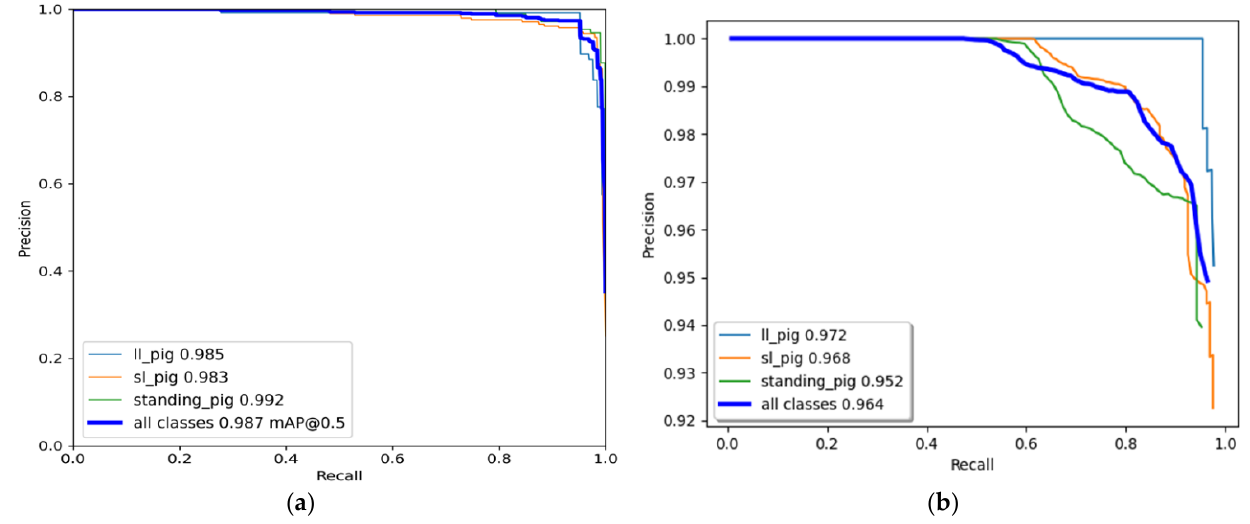
Figure 10. Class-wise and overall precision-recall evaluation metrics of the model: ( a ) YOLOv4 model and ( b ) Faster R-CNN model.